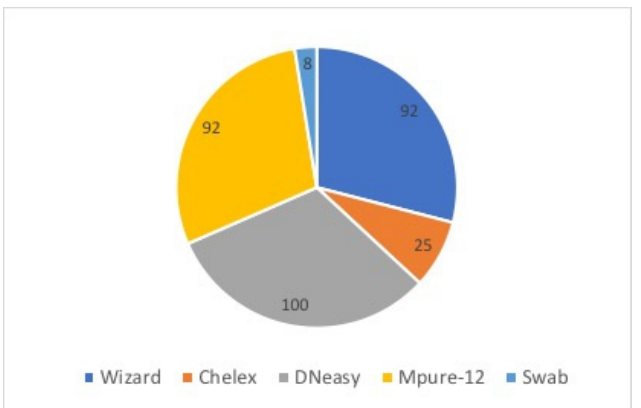
Table 2. Amplification success of PCR products of the tested species per method.